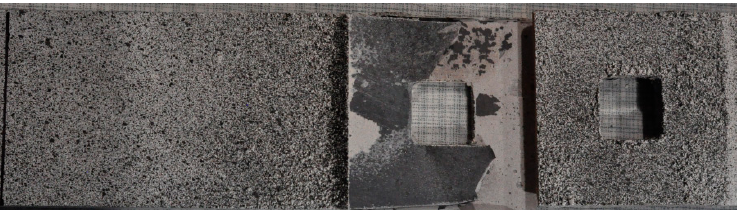
Figure 20. Final failure of sample 5.